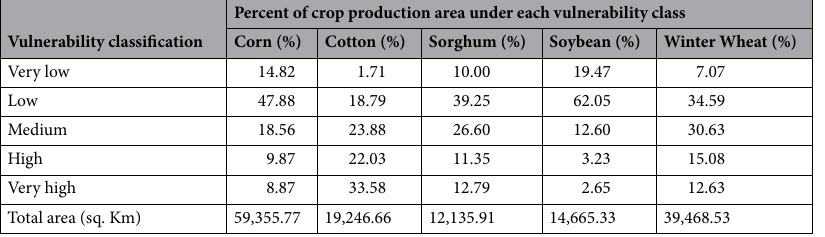
Table 1. Percentage of crop production area under each vulnerability class for five major crops grown in the ogallala aquifer